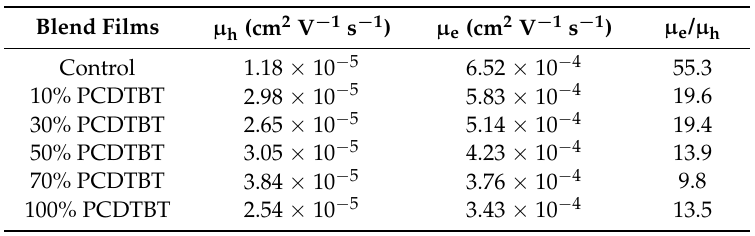
Figure 6. Dark J–V characteristics of hole-only ( a ) and electron-only ( b ) devices with different PCDTBT concentration. Table 2. The hole mobility ( µ h ) and electron mobility ( µ e ) of the binary and ternary blend films, evaluated using the Mott–Gurney law.